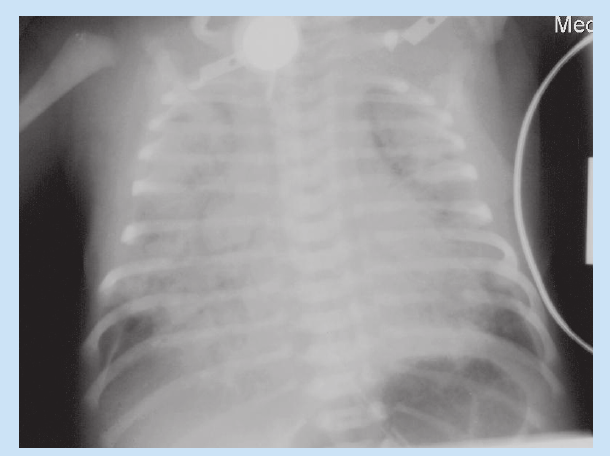
Fig. 16. Pitfall. Asymmetrical density involving one lung may be simu- lated by rotation as in this patient who actually has bilateral symmetrical ‘granular’ airspace disease in keeping with hyaline membrane disease. To determine whether the patient is rotated compare the lengths of the anterior ribs (and not the clavicular ends as done in adults).